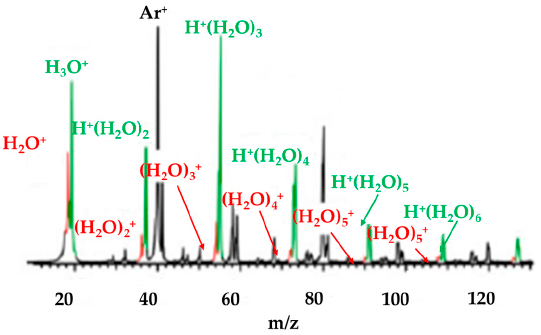
Figure 14. Mass spectrum of ions produced using the present ion source. Figure adapted from [15] with permission. Copyright 2011 The Royal Society of